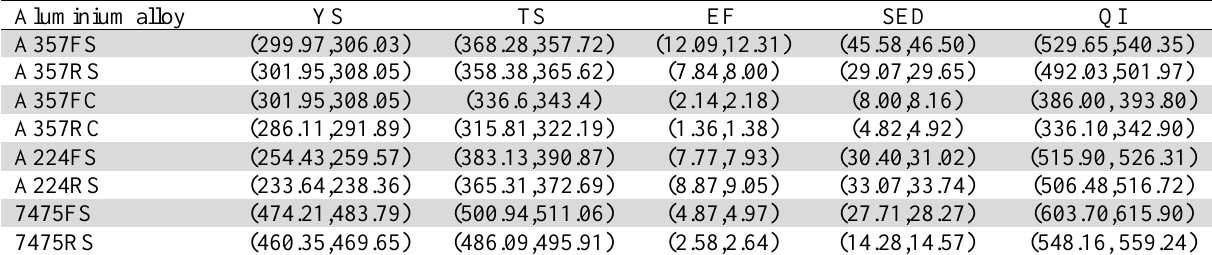
Grey decision matrix for aluminium alloys Aluminium alloy